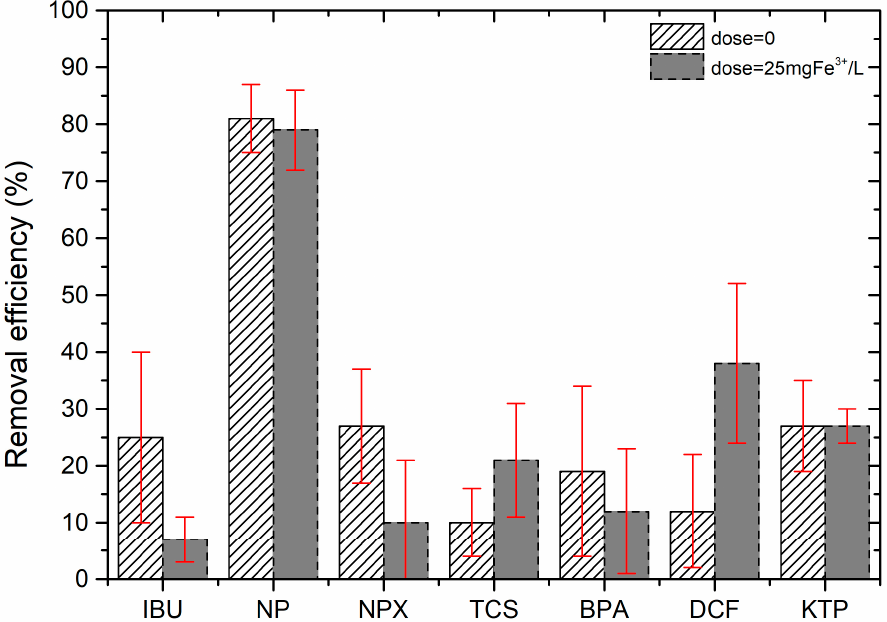
Figure 6. Removal efficiencies of 7 micropollutants with and without iron Figure 6. Removal e ffi ciencies of 7 micropollutants with and without iron addition .